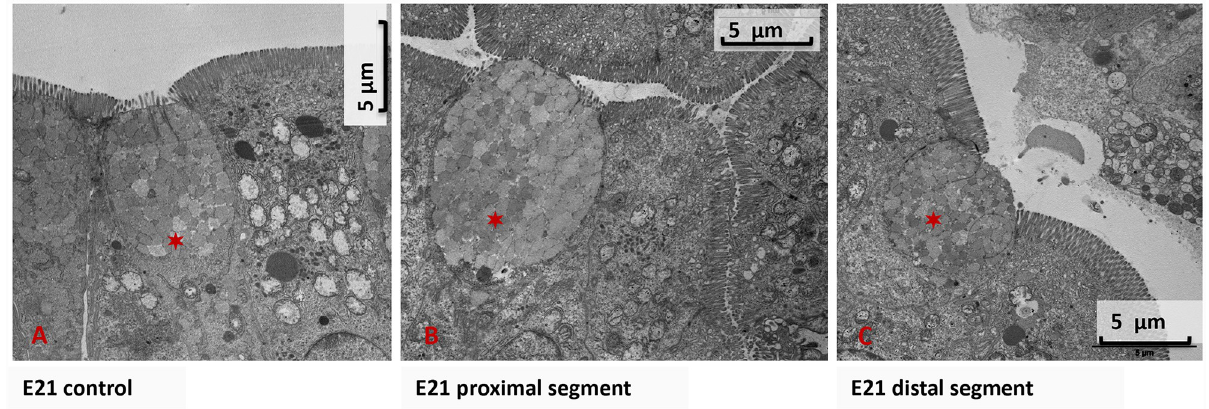
Fig 2. The ultrastructure of goblet cells: A, B, and C represent epithelium with goblet cells indicated by ✶ . A corresponds to E21 controls, B to E21 proximal segment, and C to E21 distal segment.